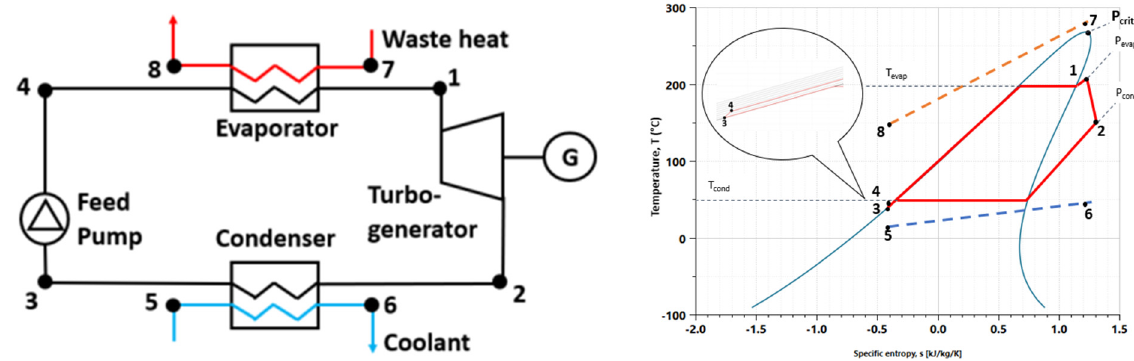
Figure 11. Simple ORC cycle configuration (sORC) and typical T-s diagram.